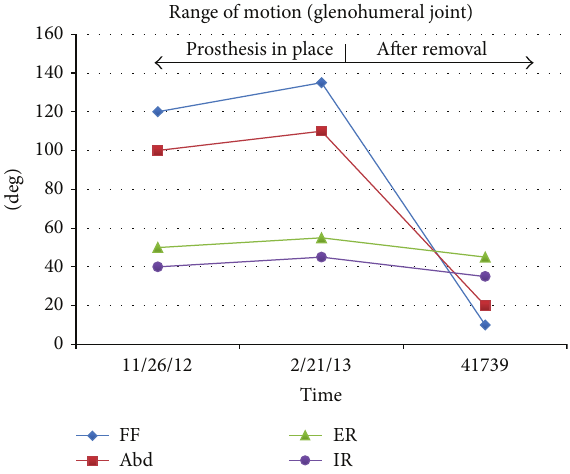
Figure 7: Range of motion (ROM) values before removal of the reverse prosthesis and one year after the cement spacer was placed. Labels are forward flexion (FF), abduction (Abd), external rotation (ER), and internal rotation (IR).